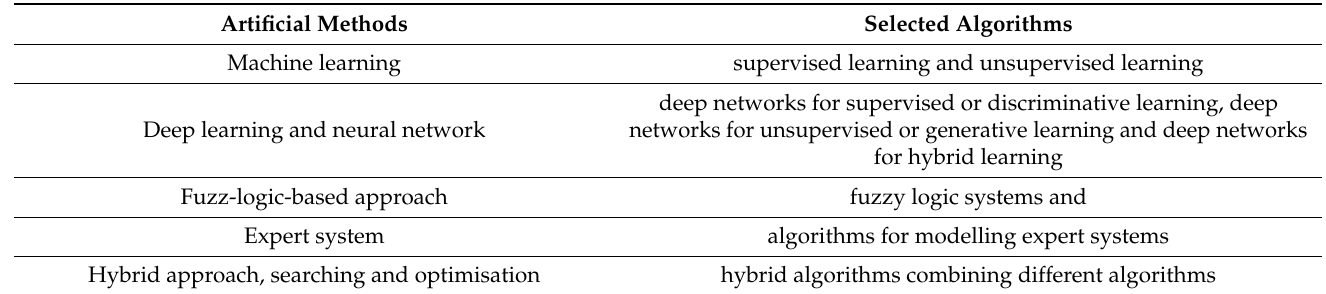
Table 4. Selected artificial intelligence methods with algorithms